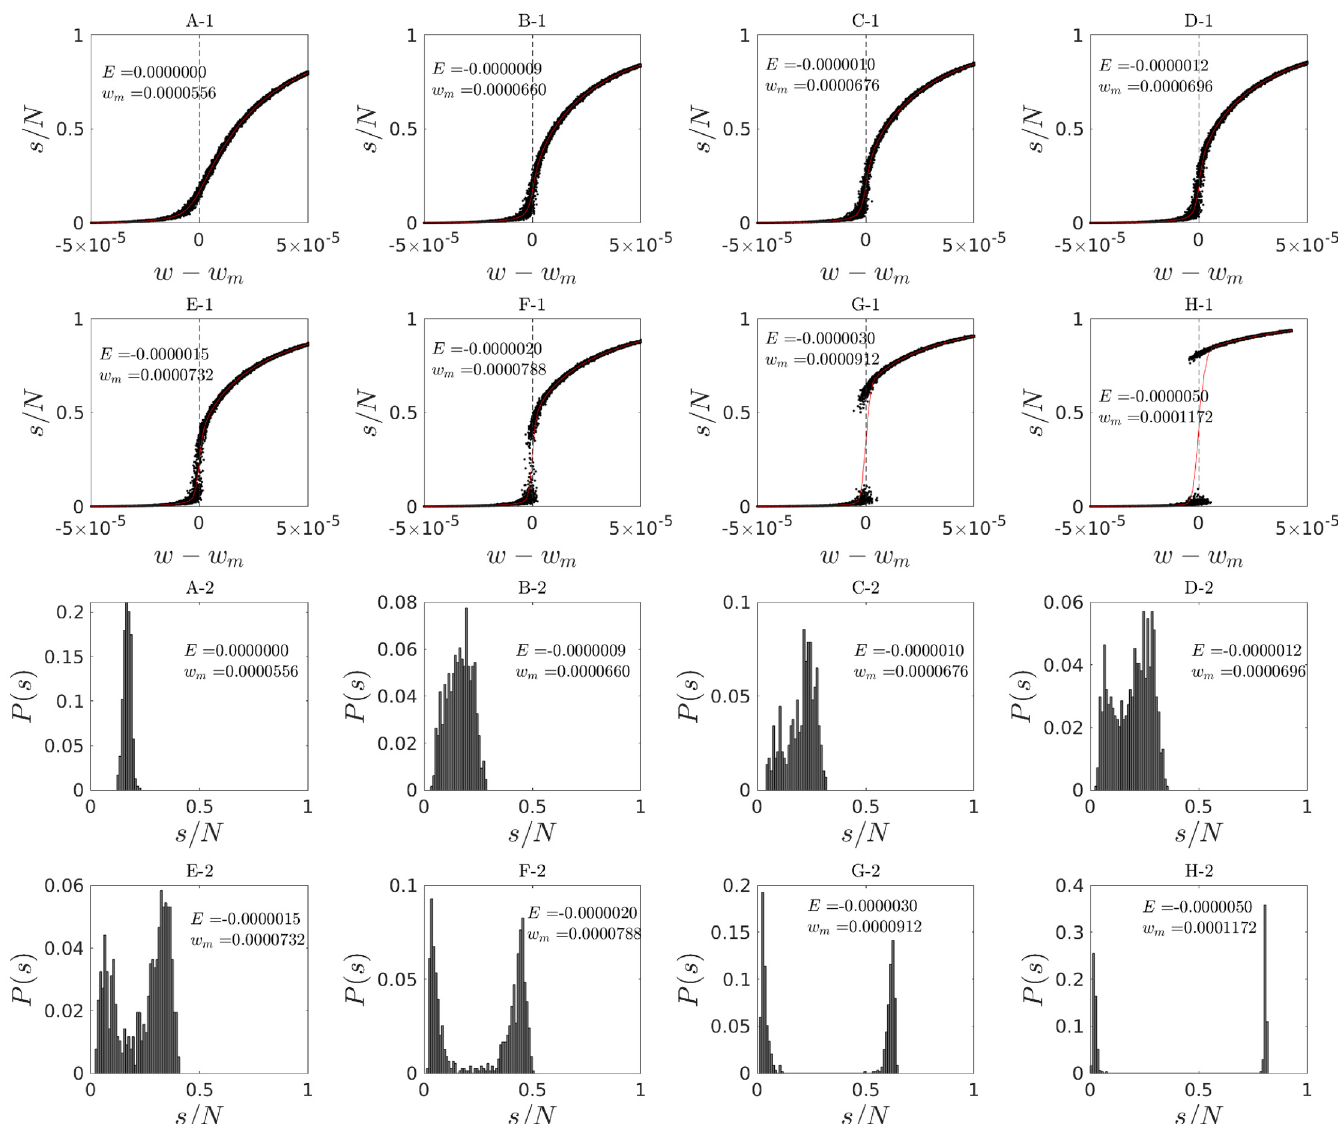
Fig 7. A-1 to H -1: Behavior of the order parameter (normalized spread size) around the point of maximum fluctuations for the mean-field approximation of a system with N = 2 15 . Each plot was obtained by keeping E fixed and varying w around the point of maximum fluctuations w m which was obtained by numerical evaluation of the standard deviation of spread sizes. Each point was obtained from the number of nodes recruited to seizure (spread size) in one realization of the mean- field dynamics. For each w we plot 50 realizations. Two distinct behaviors are observed: (1) a continuous crossover (without a singularity in the derivatives of the order parameter) for values of E close to zero, and (2) a clear discontinuous transition with a jump for E < − 1.5 × 10 − 6 . The shift from continuous to discontinuous behavior is expected to pass through a critical point of a (critical) phase transition. Panels A -2 to H -2: Transition between unimodal and bimodal probability distributions of seizure spread size. Probability distributions of normalized spread size, obtained from 300 to 500 stochastic realizations, are shown at the point of maximum fluctuations w and different values of the excitability E . A clear transition from unimodal to bimodal distributions is observed. In all simulations N = 2 15 . The locations m of the above continuous and discontinuous, as well as unimodal and bimodal, regimes in the control parameter space ( w , E ) are shown in Fig 8I and 8J with more detail.